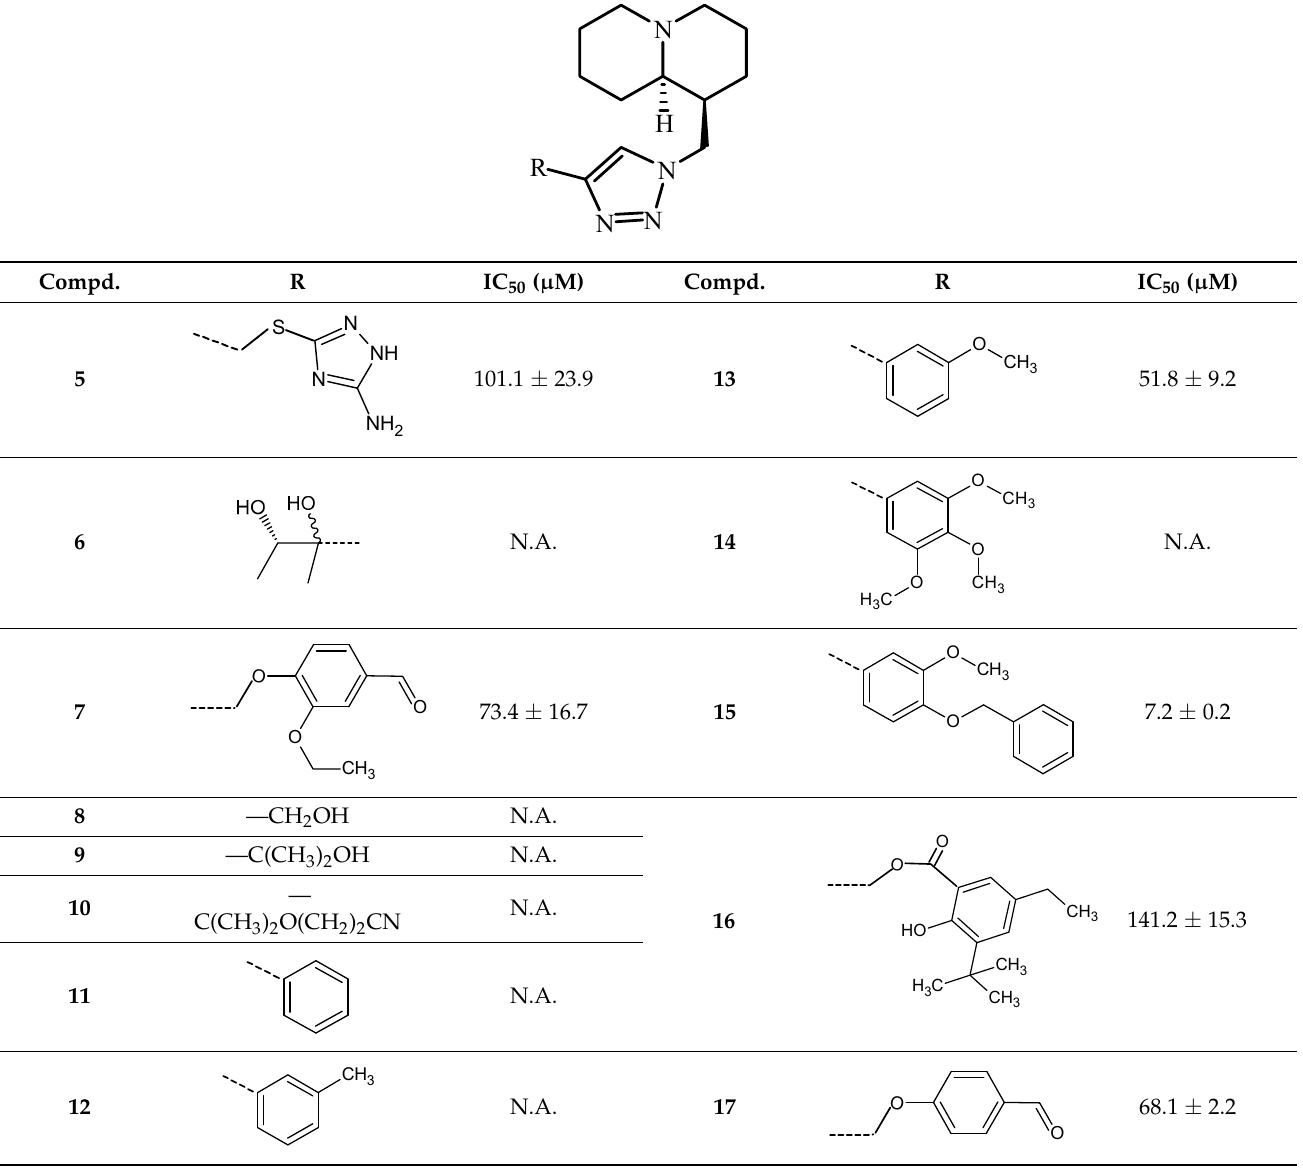
Table 1. AChE inhibitory activity of lupinine-based triazole derivatives. N H N